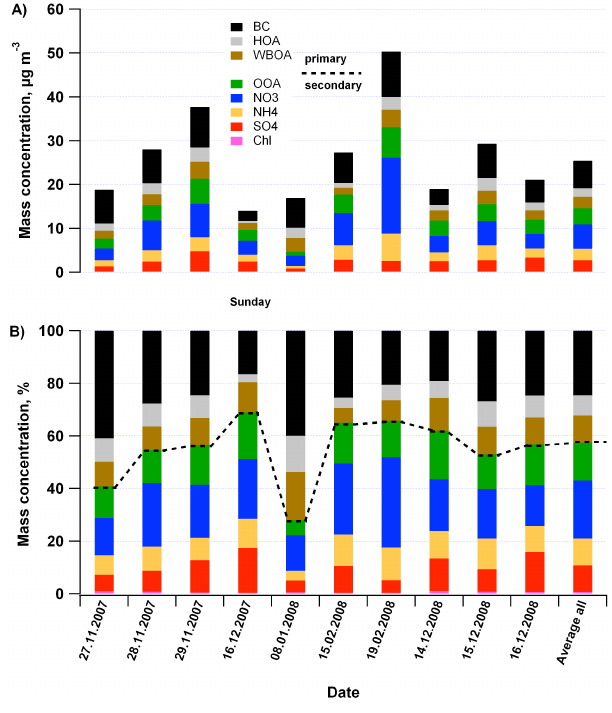
Figure 4: Absolute (A) and relative (B) composition of PM 1 , average values per measurement day (complete drive including stops at background station) and average over whole dataset (“average all”). The dashed line shows the proportions of primary and secondary components.